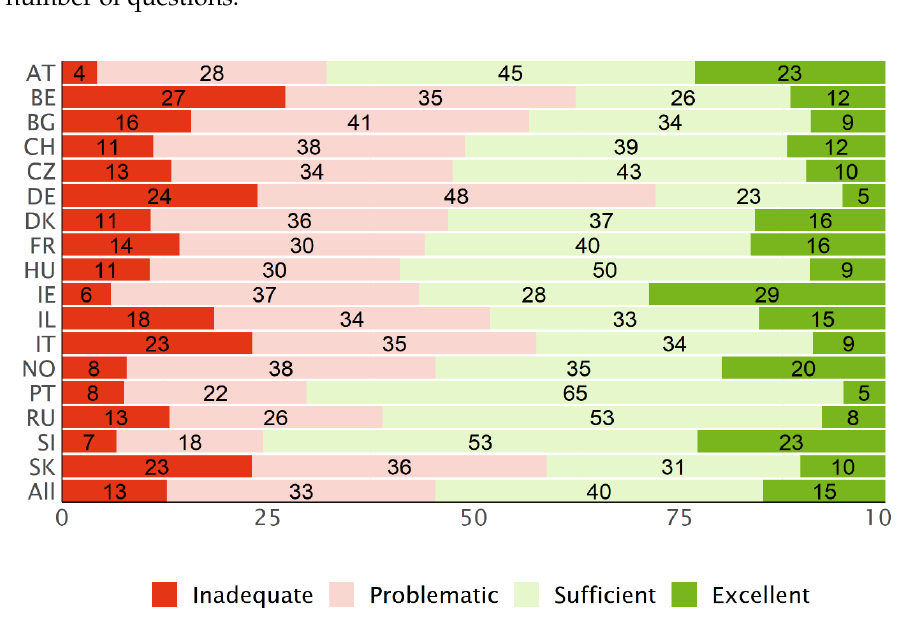
Figure 5. Distribution of the HLS 19 -Q12 levels for general HL, based on type P scores, for each coun- try and the mean for all countries. 3.4. Validity Characteristics 3.4.1. Content and Face Validity By using the theory-based matrix of the comprehensive multifaceted model of gen- eral HL for operationalization of HLS 19 -Q12, i.e., for selection of items for the respective cells of the defining matrix, the content and face validity of the HLS 19 -Q12 is ensured. 3.4.2. Discriminant Validity